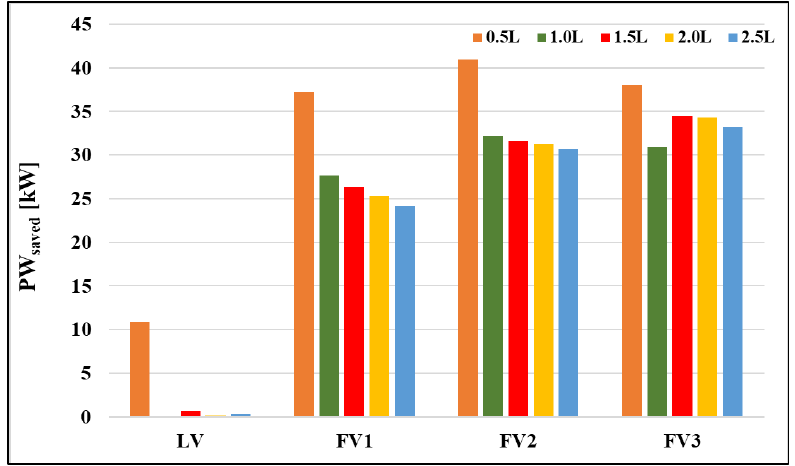
Figure 9. Tractive power (PW saved ) saved on the vehicles platooning compared to SV at 100 km/h. LV saved approximately 10 kW of power at the 0.5 L gap condition. Under 1.0 L~2.5